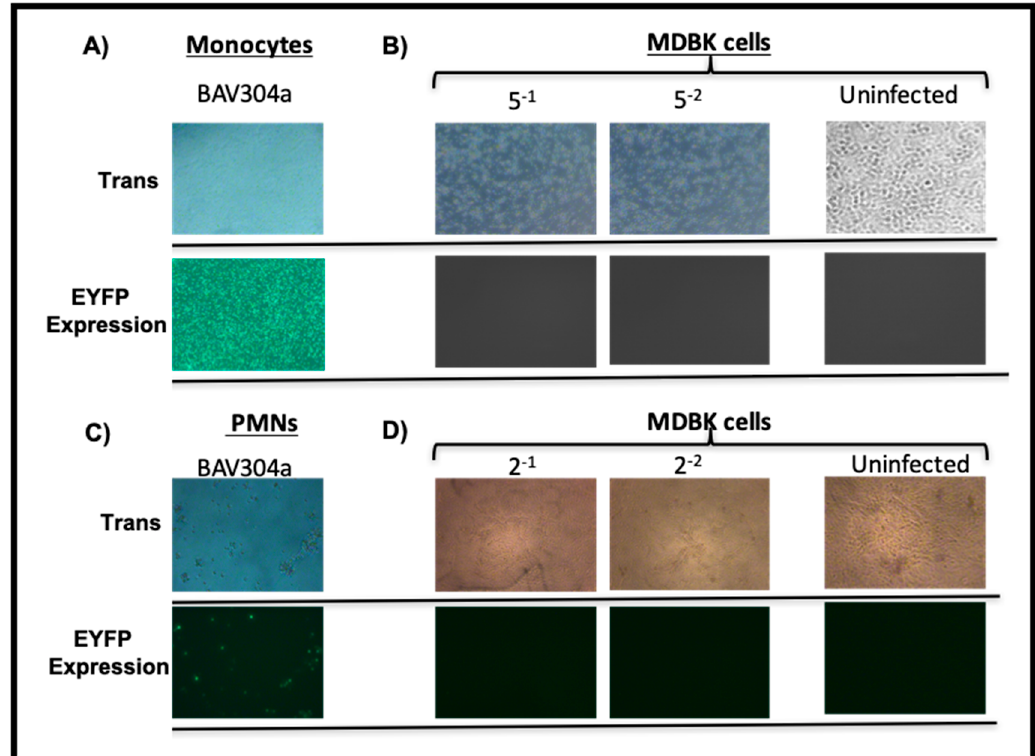
Figure 3. Replication of BAV304a in monocytes and PMNs. Purified CD14 + bovine monocytes ( A ) or bovine PMN cells ( C ) were infected with BAV304a at an MOI of 2. At 48 h post-infection, the cells were examined by light microscopy (Trans) to confirm viability and with fluorescent microscopy (EYFP expression) to confirm transduction. The infected cells were collected, freeze-thawed and the virus in infected monocyte lysates ( B ) or infected PMNs lysates ( D ) was titrated using MDBK cells. Viral infection of MDBK cells was analyzed for cytopathic effect (CPE) with light microscopy (Trans) and expression of EYFP by fluorescent microscopy (EYFP expression). Results presented are representative of two independent experiments with three replicates cultures in each experiment. Five-fold serial dilutions of monocyte lysates and two-fold serial dilutions of PMN lysates were used for virus titration on MDBK cells. Magnification in all images is 100×.